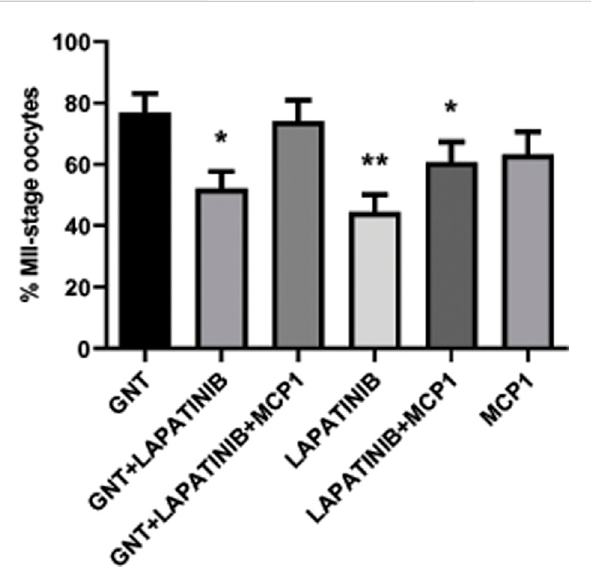
FIGURE 5 In vitro feline oocyte maturation under different treatment conditions.ProportionofmetaphaseII(MII)stageoocytesafter28 hin culture, inthepresence orabsence ofapositive stimulus (GNT),adual EGFR inhibitor (LAPATINIB), and/or recombinant chemokine MCP1, assessed by IF (expressed as mean percentage ±SEM, n = 306 total COCs). Generalized linear model, logistic regression, was used to evaluate a treatment effect on maturation to MII. * p -value < 0.05 compared to GNT; ** p -value < 0.001 compared to